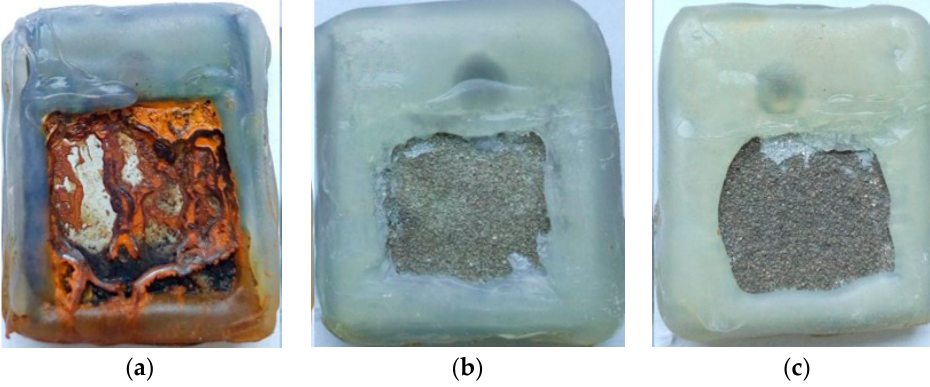
Figure 4. The digital photos of the coatings after 720 h of neutral salt spray test (NSS test) showing e ff ective protection of the coatings against corrosion (( a ): mild steel plate without coating, ( b ): the Al coating, and ( c ): the Al-CF coating).